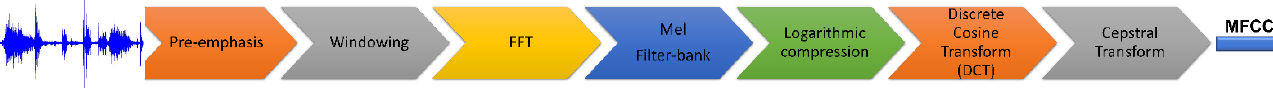
Figure 2. Block diagram of MFCCs feature extraction modules.